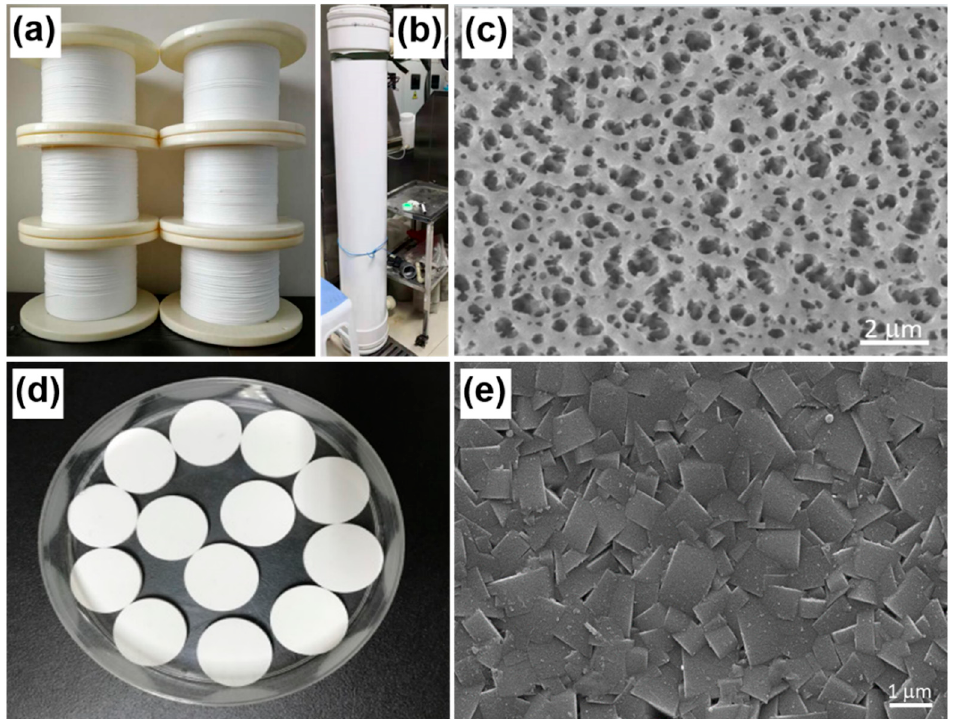
Figure 12. Photographs of ( a ) PTFE hollow-fiber membrane and ( b ) the membrane module. ( c ) Scan- and ( e ) SEM surface image of the MFI-type zeolite membrane (unpublished work). Table 3. Summary of some typical ceramic membrane projects in